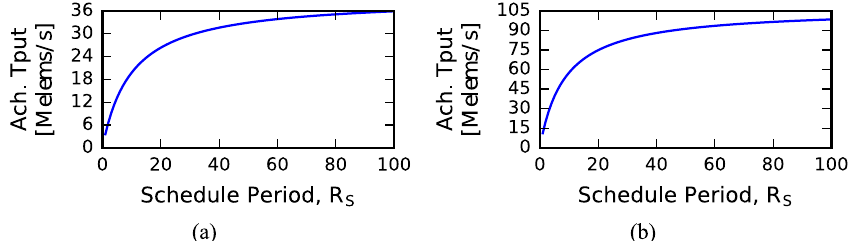
Figure 15. Total achievable throughput prediction plots vs. schedule period for two applications. ( a ) COS with C = 10, N = 10 C , S = 100 ( b ) AES with C = 14, N = 8 C , S =